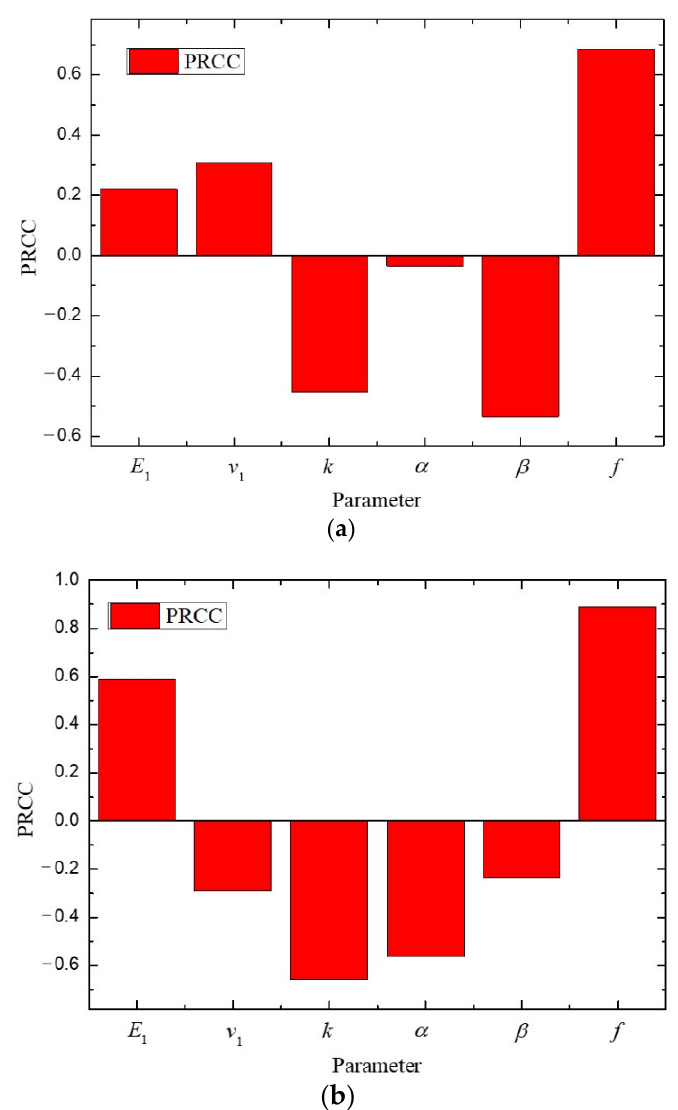
Figure 7. The Partial Rank Correlation Coefficient (PRCC) sensitivity analysis for the ( a ) bulk modulus and ( b ) shear modulus in the C30 concrete.